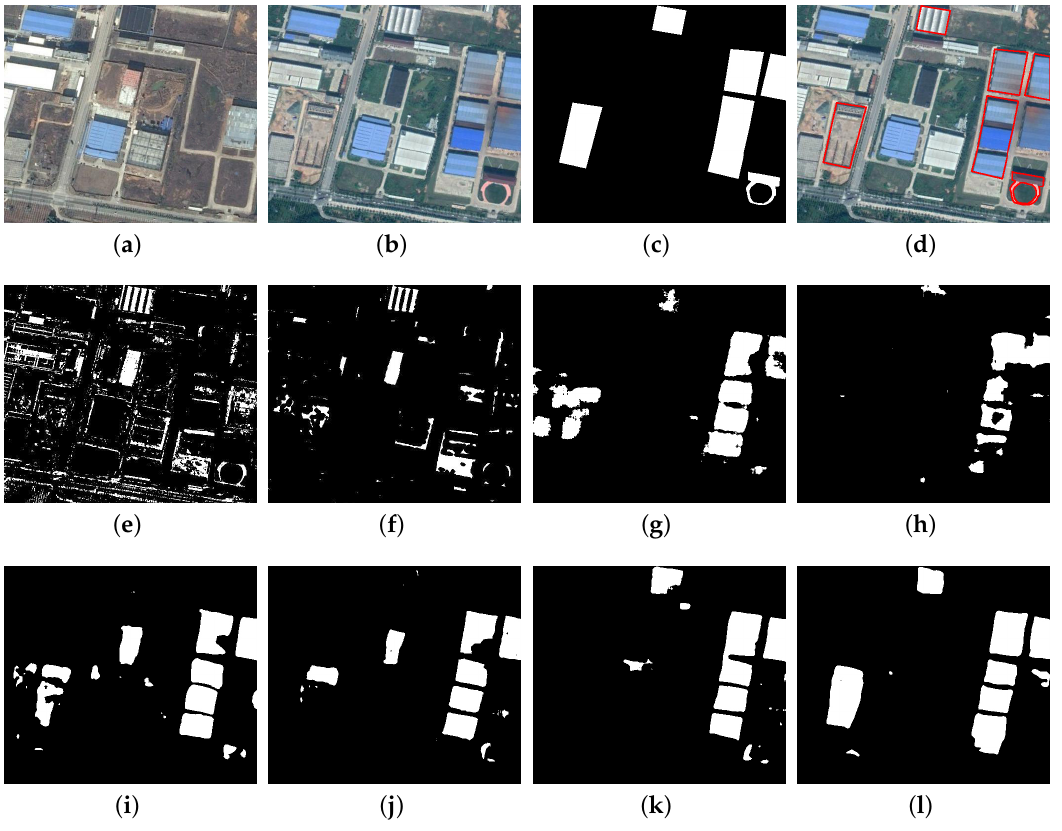
Figure 11. Comparison of prediction maps for different algorithms. Panels ( a,b ) are Google Earth images of the same place at different times; panel ( c ) is the ground truth, in which the black areas represent the unchanged, and the white areas represent the changed. The changed areas are framed by red lines in panel ( d ). Panels ( e – l ) are the prediction maps of different algorithms, which are, respectively, ( e ) IR-MAD, ( f ) PCA-means, ( g ) SegNet, ( h ) FCN8S, ( i ) HRNet, ( j ) UNet, ( k ) UNet_att, and ( l )